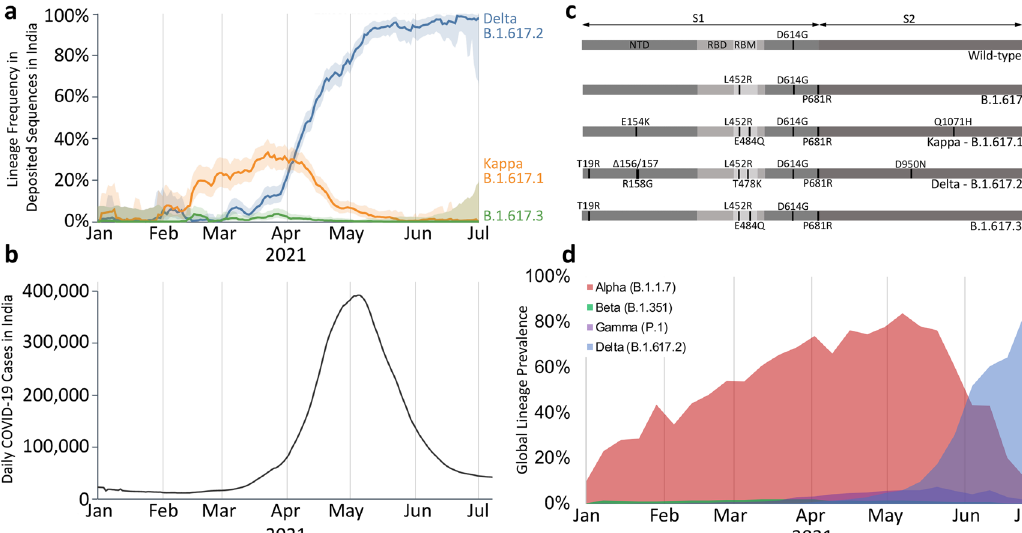
Fig. 1 Emergence and prevalence of the Delta and Kappa SARS-CoV-2 lineages. a Delta (B.1.617.2), Kappa (B.1.617.1) and B.1.617.3 lineage frequency in India from January to July 2021. Deposited sequences were downloaded from the GISAID initiative. The 95% con fi dence interval is plotted as the lighter shaded border around each line. This fi gure panel was generated using the outbreak.info project 3 . b Daily con fi rmed COVID19 cases in India as curated by the outbreak.info project 3 . c SARS-CoV-2 amino acid sequence box plots for the wild-type (D614G) and B.1.617 sub-lineages. The abbreviations are NTD N-terminal domain, RBD receptor-binding domain, RBM receptor-binding motif. d Global prevalence for the Alpha, Beta, Gamma and Delta lineages of SARS-CoV-2 from January to July 2021. The sequence data were downloaded from the GISAID initiative and plotted as the percentage of the global prevalence for each week 1,2